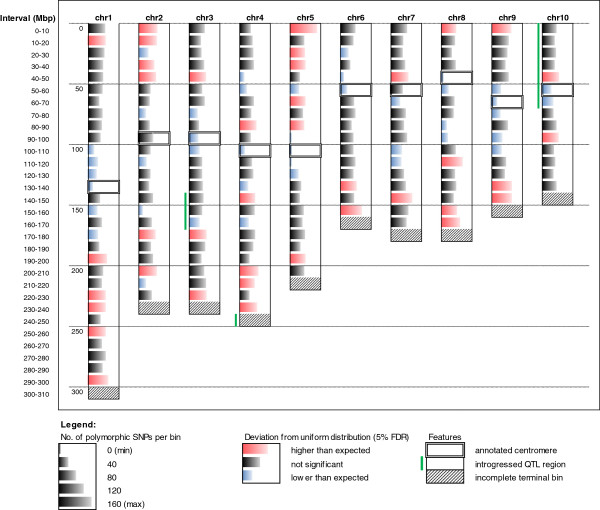
Distribution of polymorphic SNP within chromosomes. Bin size: 10 Mbp. Bin colors indicate significant non-uniform distribution of SNPs (see text). Red: over-representation of polymorphic SNPs; Blue: under-representation of polymorphic SNPs. Thick boxes indicate bins containing the annotated centromeres; green vertical bars denote bins containing the introgressed QTL; grey rectangles indicate incomplete terminal bins (excluded from tests).